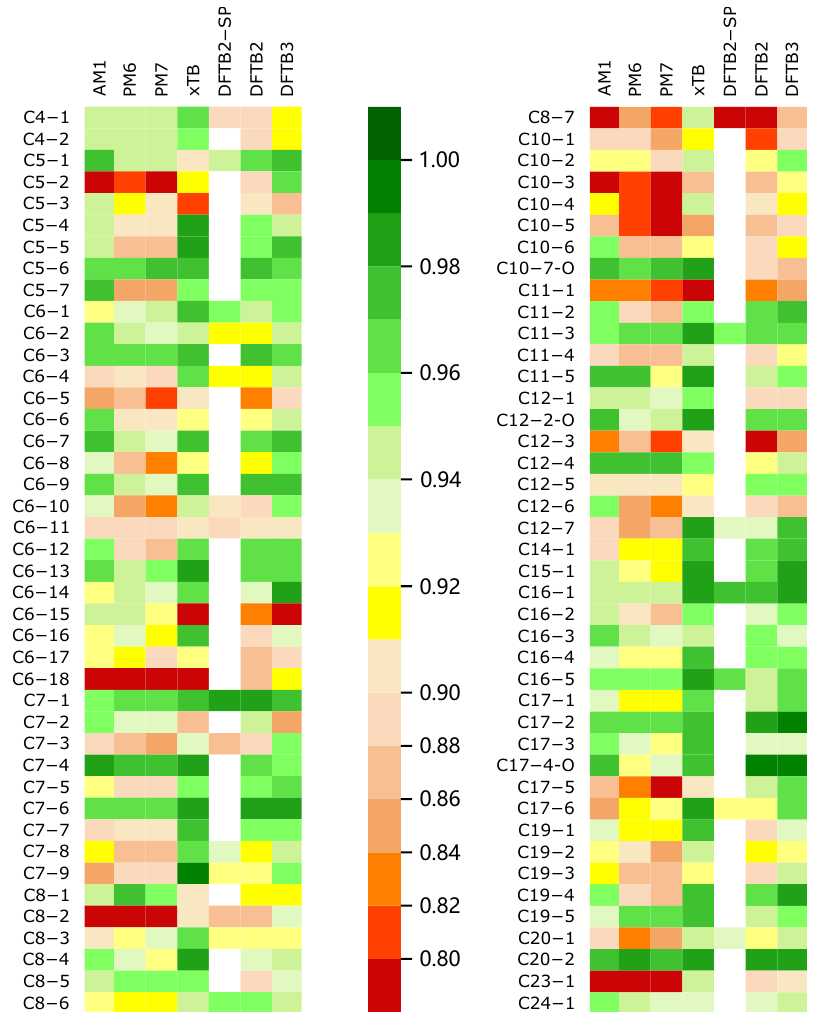
Figure 2. All soot trajectories were calculated by different semi-empirical methods for the energy profiles and the energy profiles were plotted. The DFT method (M06-2x) was used as a reference to score all the profiles; the result of M06-2x had a score of 1.00; a method with a score closer to 1.00 when calculating the energy change was relatively superior; the color appears to be a darker green, and the opposite is closer to